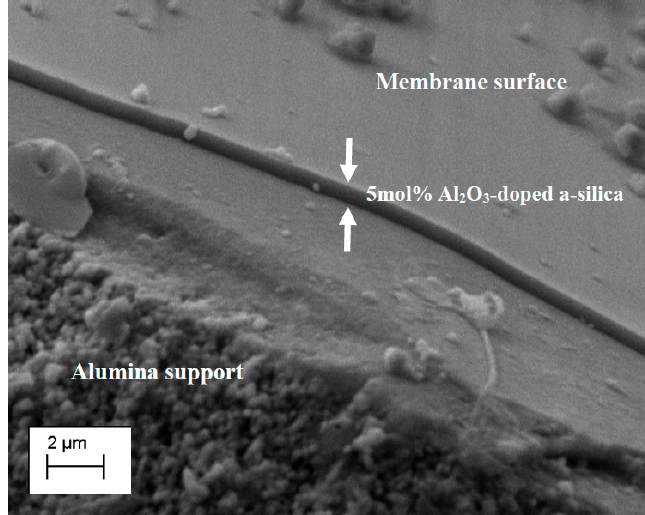
Figure 4. Cross-sectional SEM micrograph of the membrane obtained by coating a 5 mol% Al 2 O 3 -doped silica sol with a surfactant/oxide ration (S/O) of 0.25 and an oxide (SiO 2 + Al 2 O 3 ) concentration of 11.8 g·L − 1 . White arrows indicate the 5 mol% Al 2 O 3 -doped silica layer.